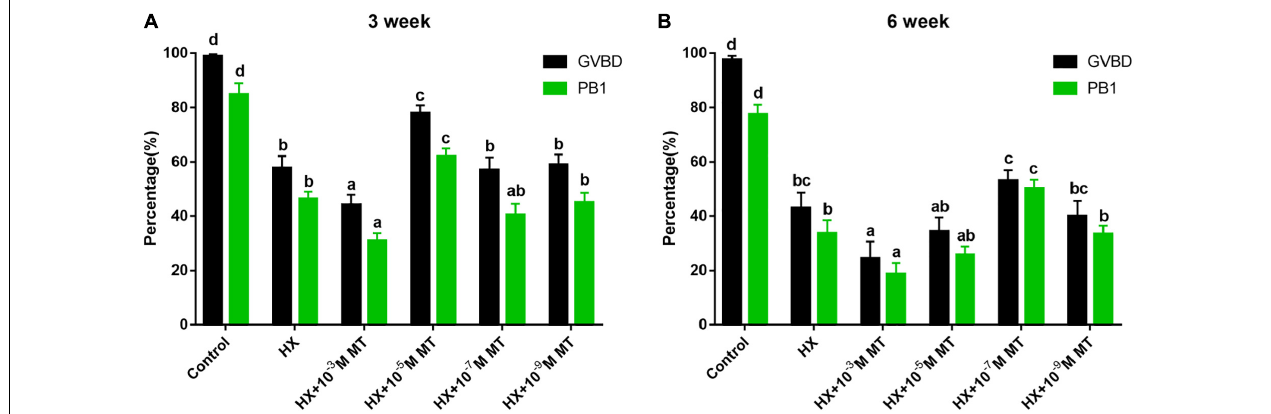
FIGURE 1 | The effect of melatonin on the meiosis of mouse oocytes in the presence of HX. GVBD and PB1 during oocyte maturation. (A) Three-week-old. Control ( n = 153), HX ( n = 153), HX + 10 − 3 M, MT ( n = 159), HX + 10 − 5 M, MT ( n = 154), HX + 10 − 7 M MT ( n = 158), HX + 10 − 9 M MT ( n = 161). (B) Six-week-old mice. Control ( n = 152), HX ( n = 148), HX + 10 − 3 M MT ( n = 149), HX + 10 − 5 M MT ( n = 158), HX + 10 − 7 M MT ( n = 152), HX + 10 − 9 M MT ( n = 153). HX, 4 mM hypoxanthine; MT, melatonin. Data represents the mean with SEM. Different superscript letters (a–d) in each column present significant differences. ( P < 0.05) determined by one-way ANOVA followed by Tukey post hoc comparisons.